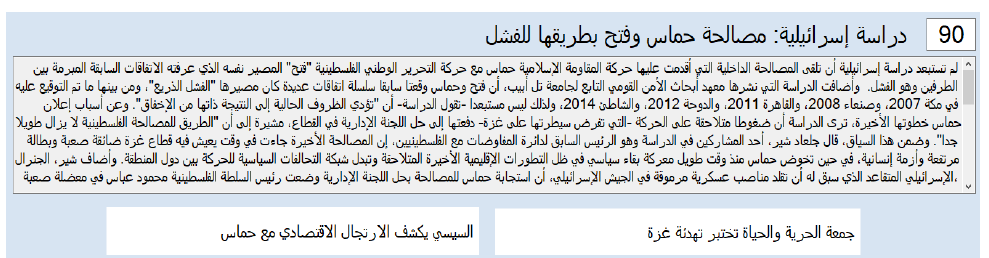
Figure A7. Sample number 5.